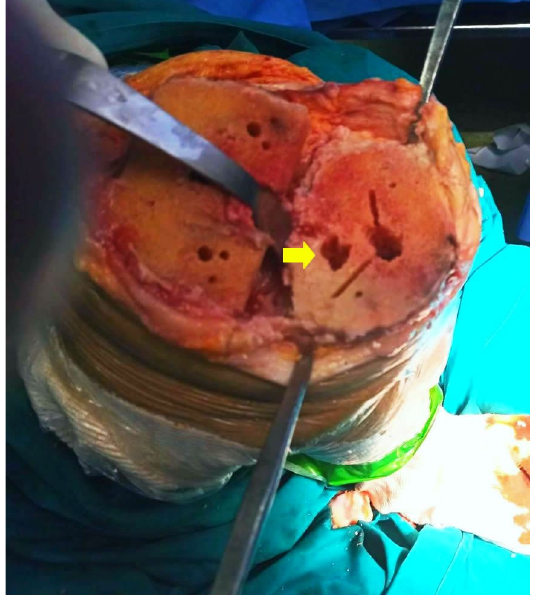
Figure 3. Intraoperative image during total knee arthroplasty demonstrating the gross appearance of a large subchondral bone cyst (yellow arrow). The remaining holes are the result of the femur and tibia preparation before implantation.